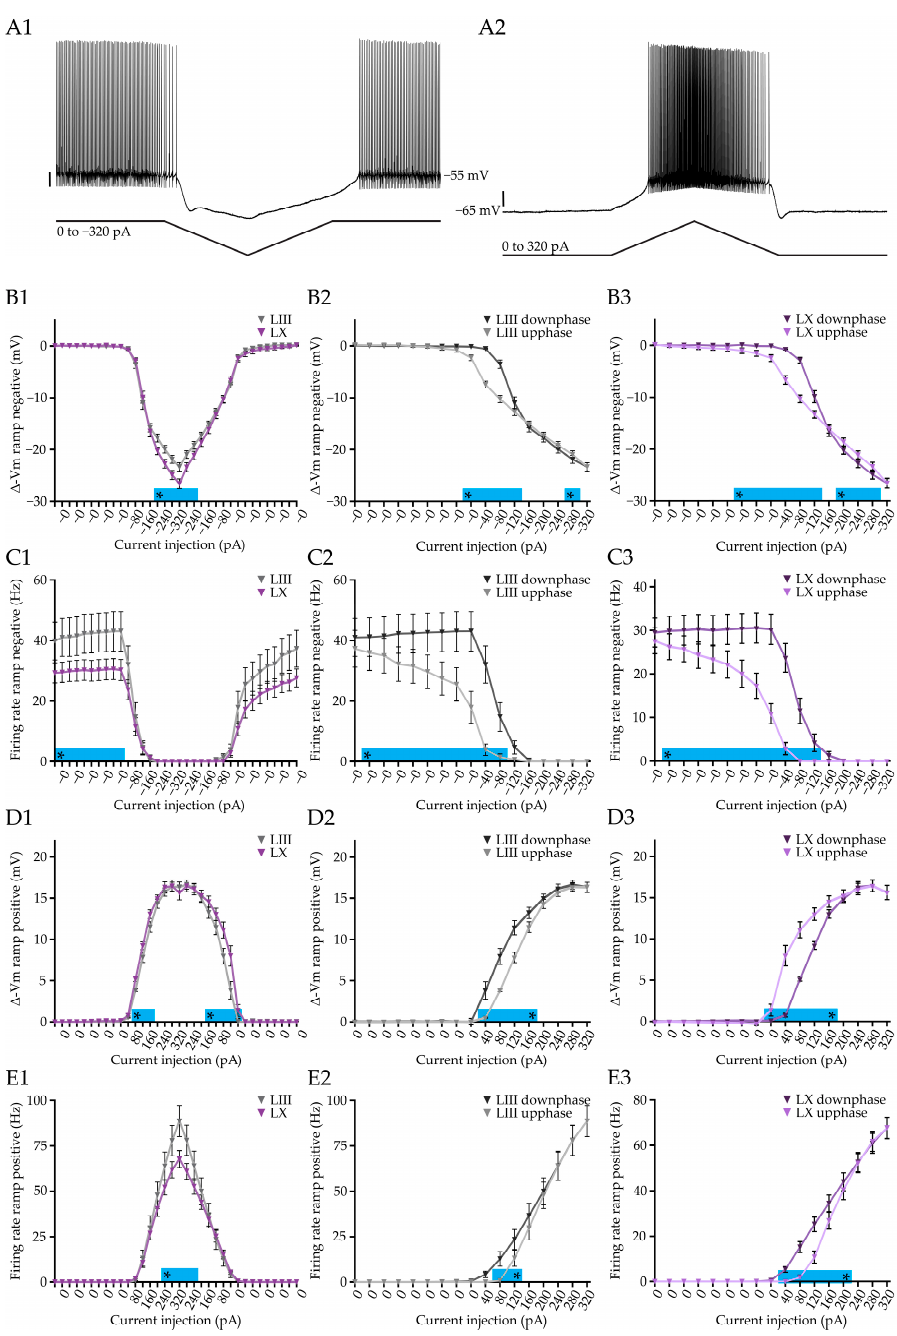
Figure 3. History-dependent integration of current in Purkinje cells. ( A ), Example traces for negative ( A1 ) and positive ( A2 ) current ramps, used to test history-dependent current integration. ( B ), Com- parison of negative current ramps starting from a resting membrane potential of − 55 mV between subpopulations ( B1 ) and comparing the downphase and the upphase for LIII ( B2 ) and LX ( B3 ) PCs. ( C1 ), Similar to ( B1 ), but now for the firing rate. In ( B2 , B3 , C2 , C3 ) significant differences indicate that the voltage response and firing, respectively, are dependent on the previous state, and thus history-dependent. ( D ), Plots of voltage change induced by positive current ramps starting from − 65 mV, comparing LIII and LX ( D1 ) and the upphase and downphase for LIII ( D2 ) and LX ( D3 ). ( E1 , E2 , E3 ), Similar to ( D1 , D2 , D3 ), but now for the firing rate of the recorded PCs. Vertical scale bar in ( A1 ), 10 mV; ( A2 ) 10 mV. Asterisk denotes p < 0.05. See Table S3 for all statistical